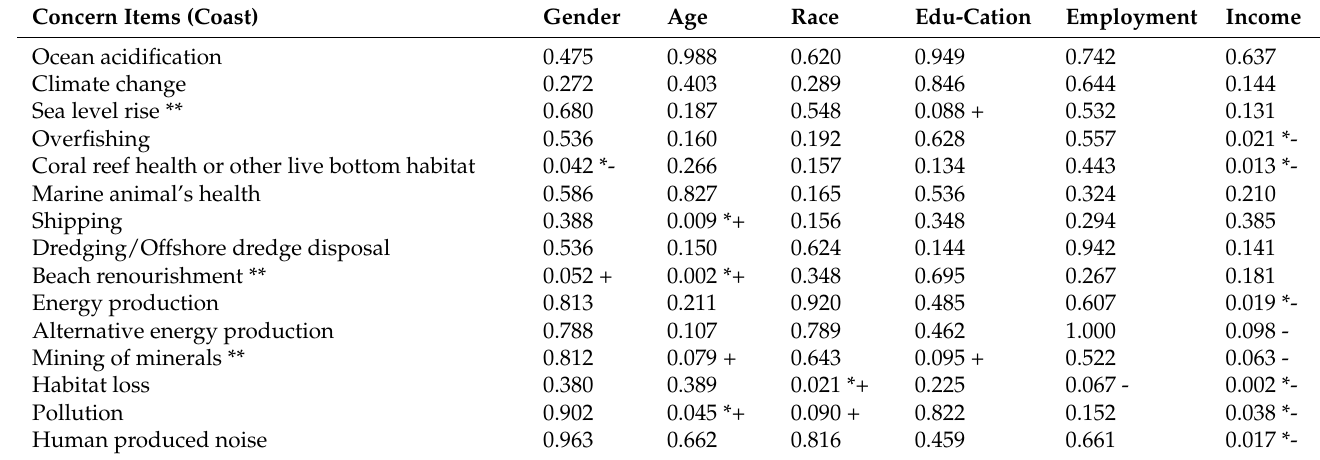
Table 5. Results of the Multiple Linear Regression Analyses for Marine Environmental Concern Levels Outside of GRNMS/ in Coastal Georgia. p -values are shown with significant items noted and described